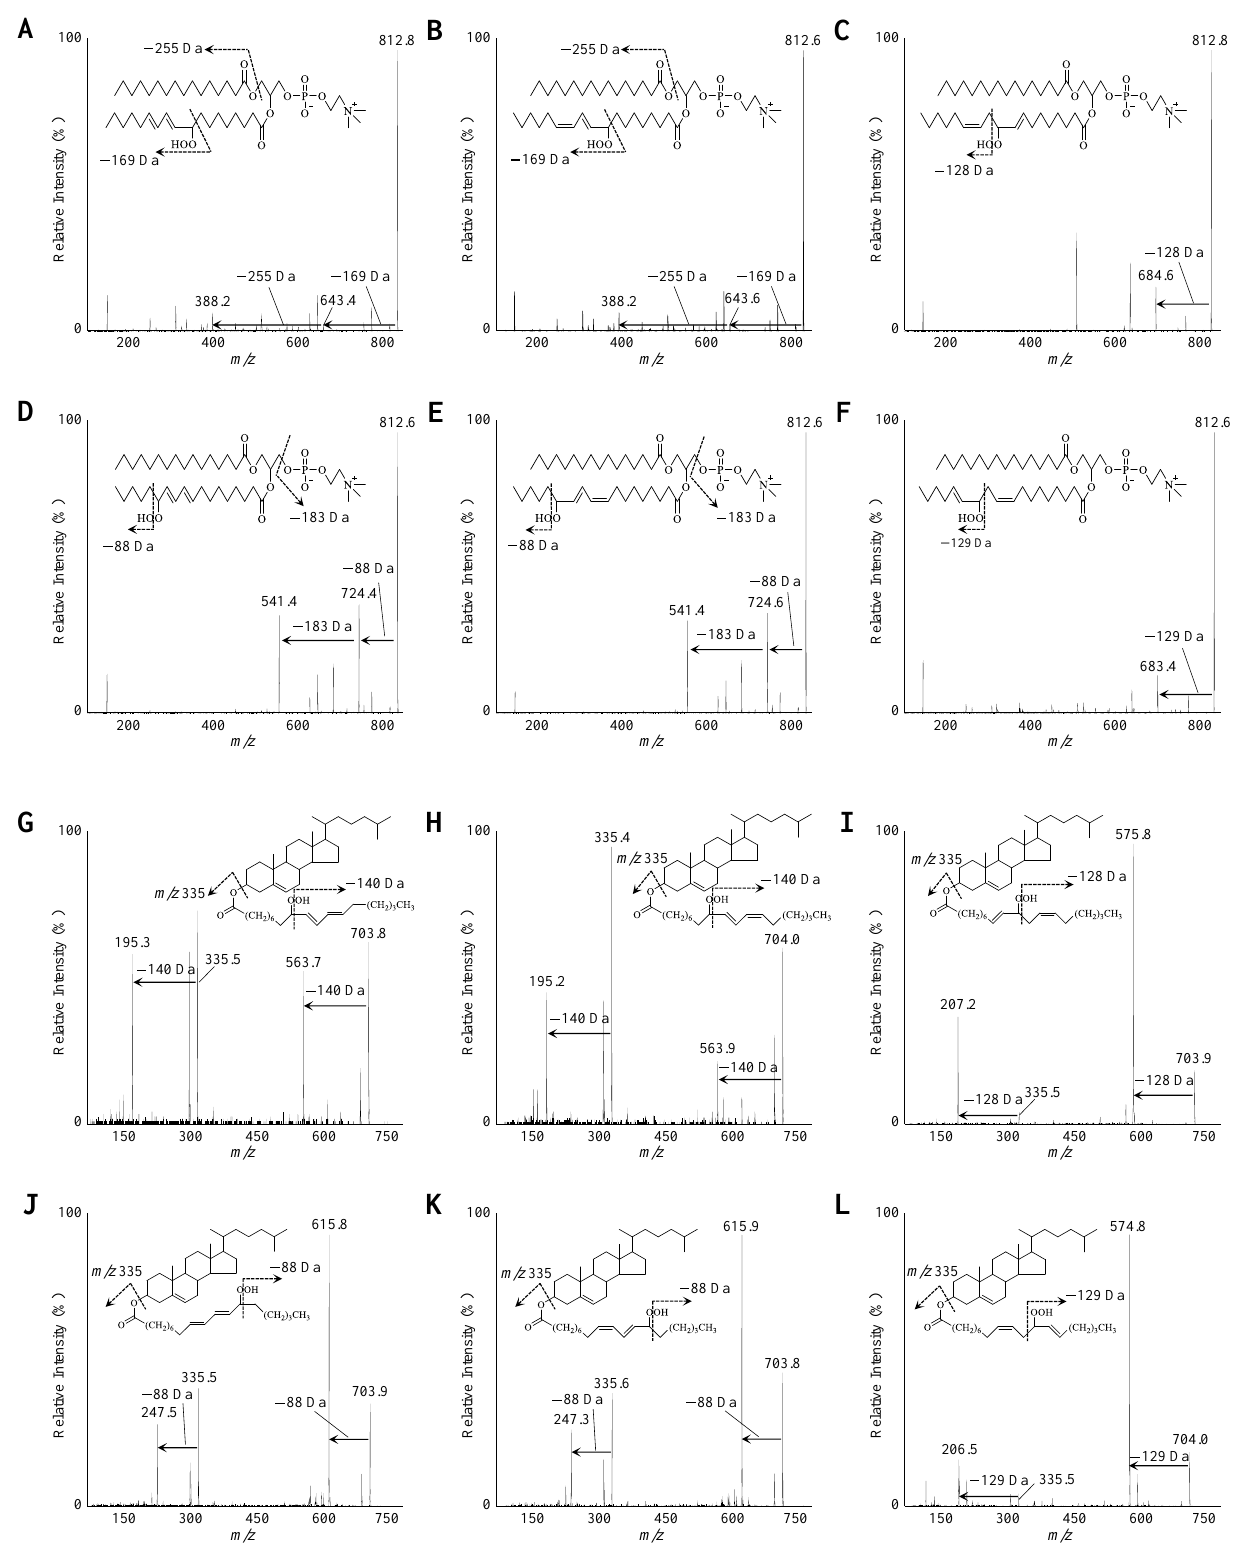
Figure 2. The product ion mass spectra of reference PC 16:0/18:2;OOH ( A – F ) and CE 18:2;OOH isomers ( G – L ). Reference PC 16:0/18:2;OOH and CE 18:2;OOH isomers were dissolved in methanol (1 µ M) and infused directly into the MS/MS system at a flow rate of 10 µ L/min. Insets show the speculated fragmentation patterns of PC 16:0/18:2;OOH and CE 18:2;OOH